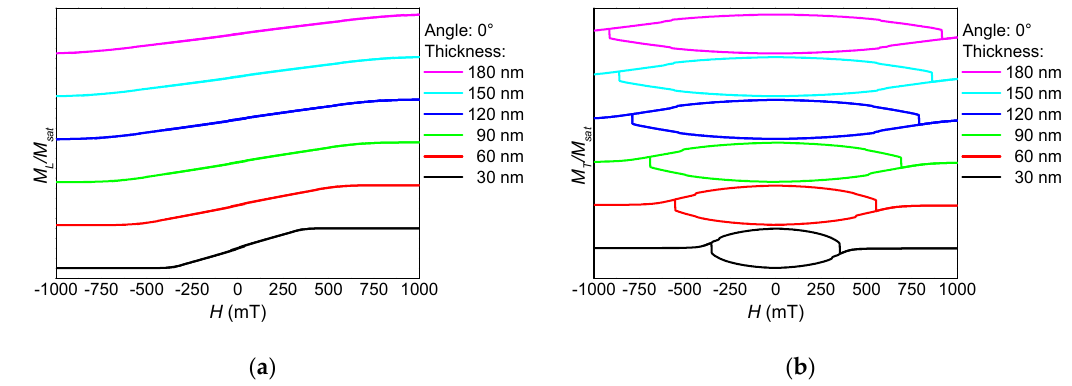
Figure 6. Thickness dependence of ( a ) the longitudinal and ( b ) the transverse hysteresis loops, simulated for sample NF2 under an angle of 0°.